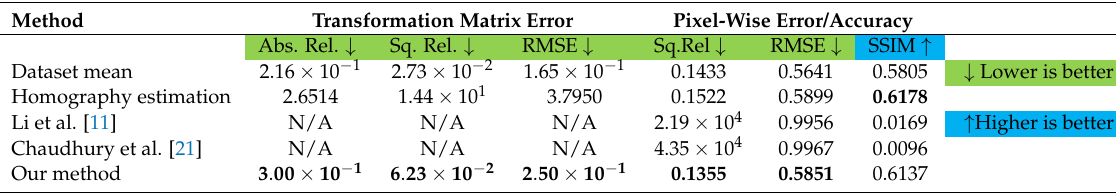
Table 6. Accuracy metrics using Places205 dataset [48]. Best performance in bold. Our network was not trained using images from Places205, but still outperforms other